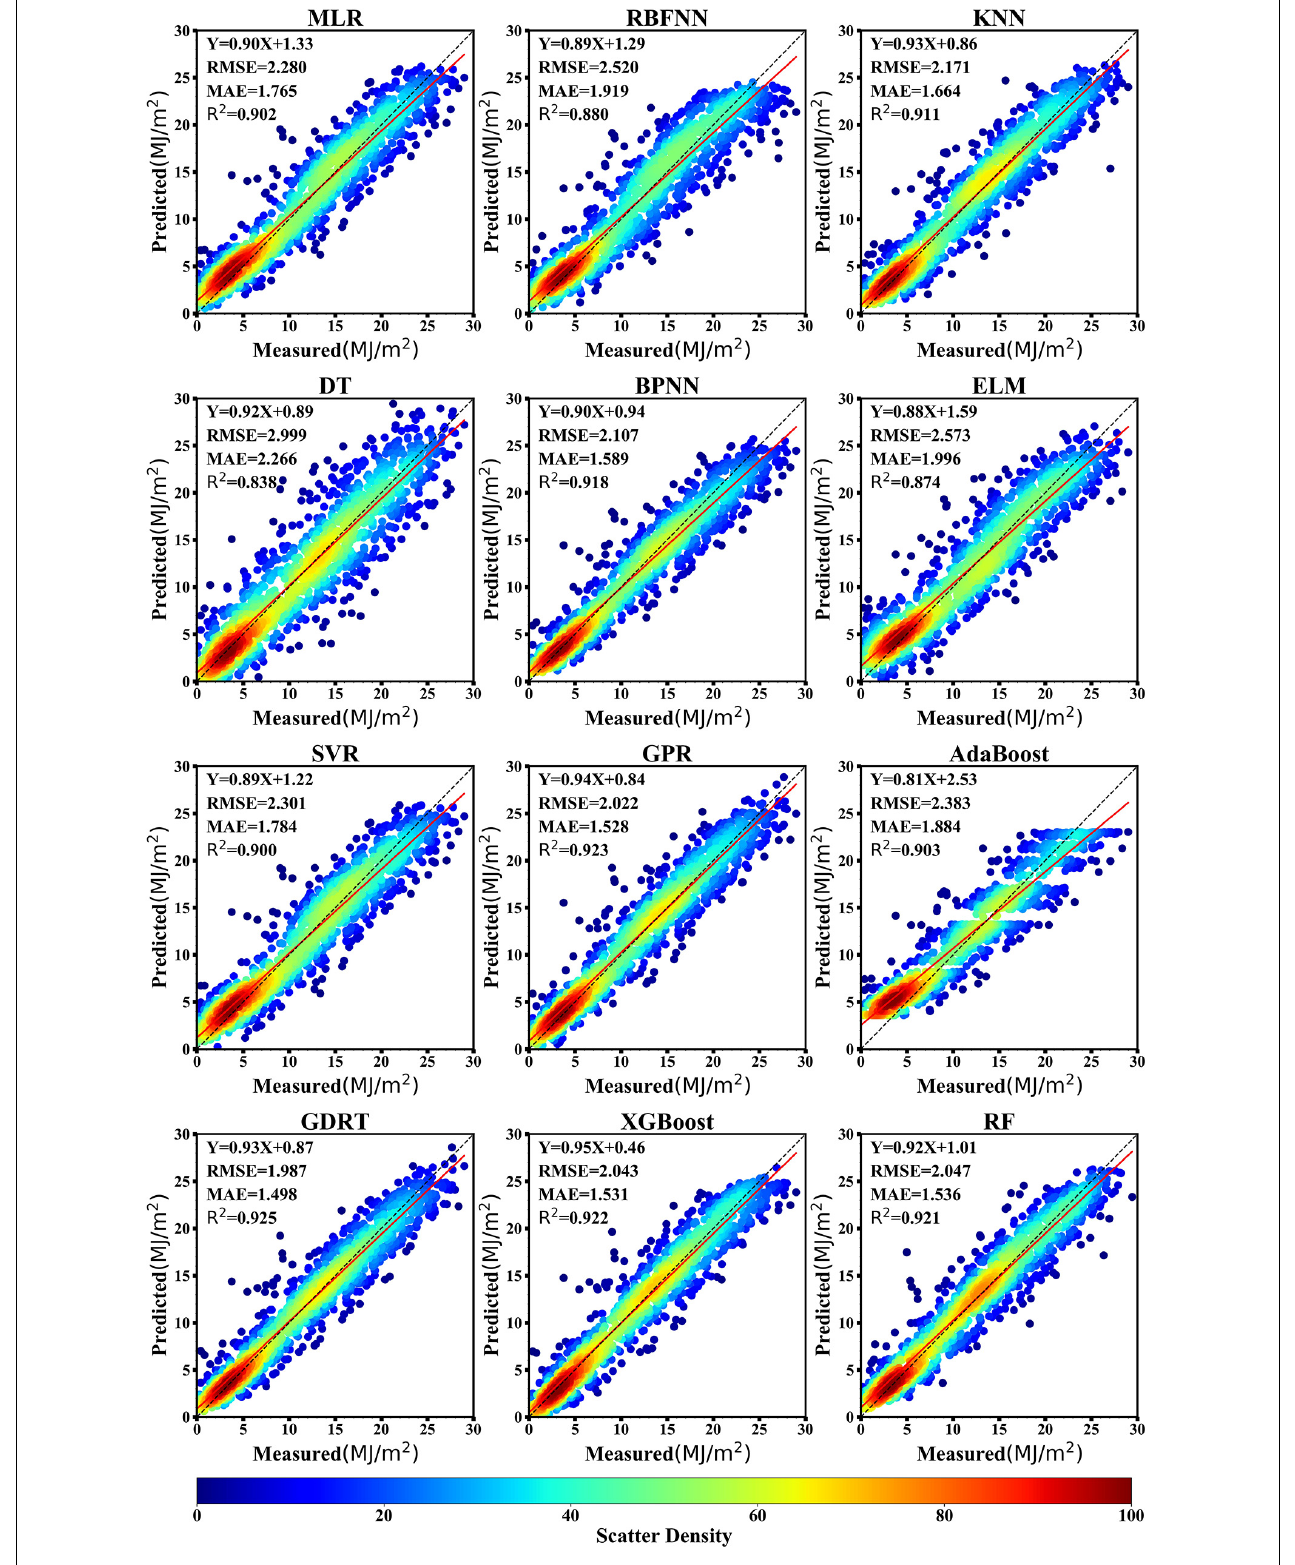
FIGURE 6 | Scatter plots of the cross-validation results for 12 machine learning models in predicting daily solar radiation at Ganzhou from 1980 to 2016.